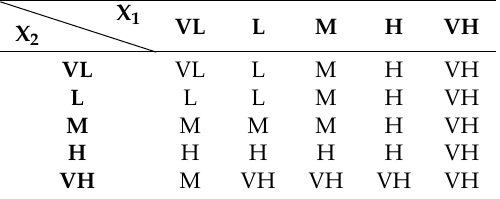
Table 3. Maximum rule-based mechanism for water supply pipeline risk index fuzzy